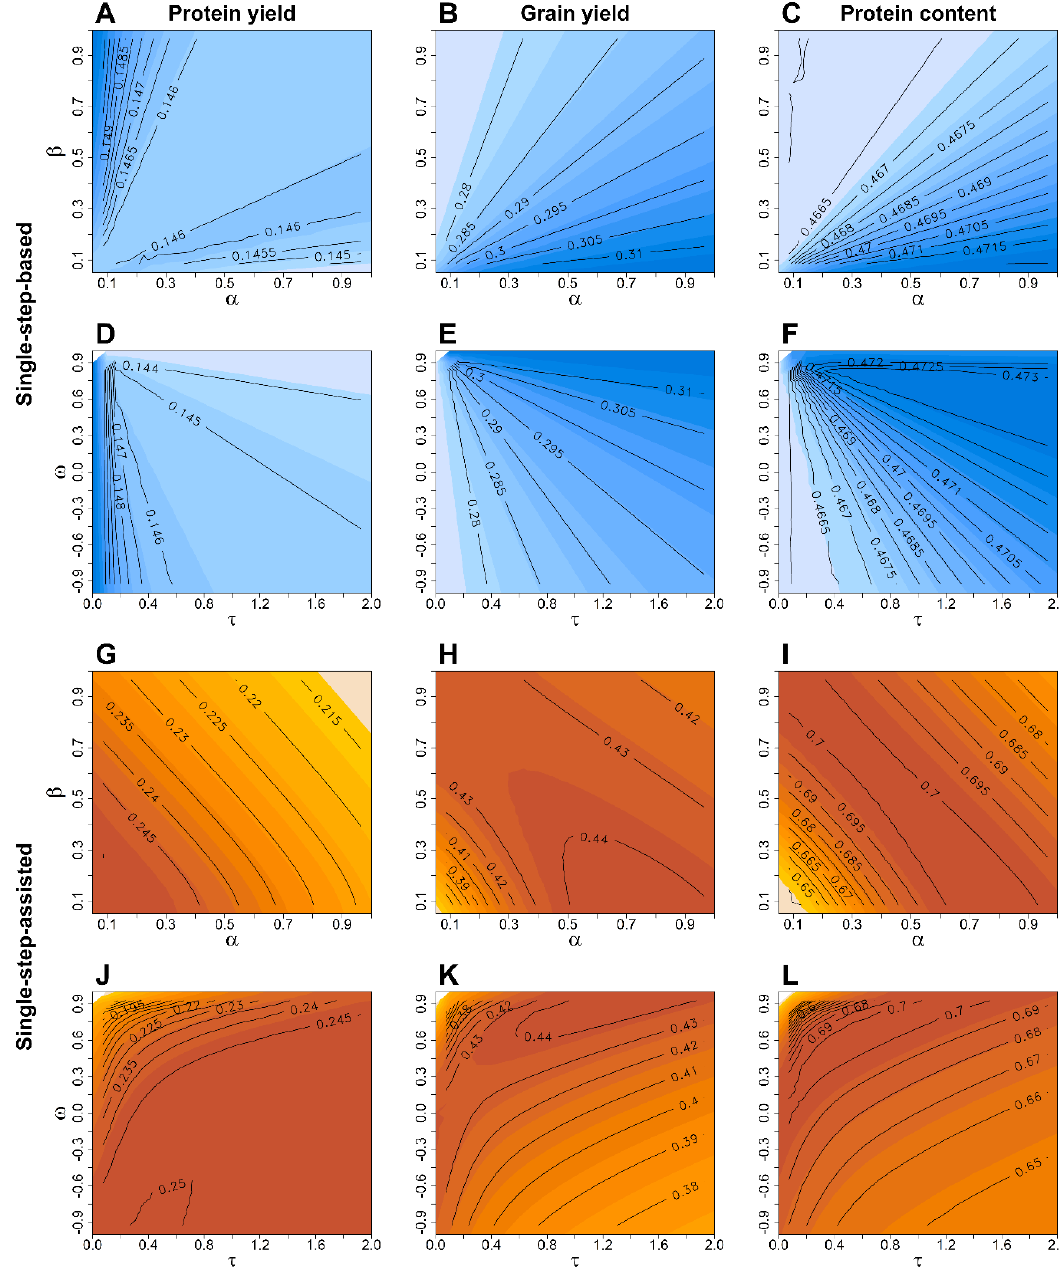
Figure 3. Average prediction accuracy for protein yield (first columns), grain yield (central column) and protein content (right column) obtained from the 50 times repeated resampling scheme with a 3-year training population in a single-step genomic prediction scenario where only lines in the training population are genotypes to derive single-step-based ( A – F ; blue coloured) and single-step-assisted predictions ( G – L ; red coloured) for the non-genotyped lines in the validation population with the latter exploiting preexisting information of the validation population from preliminary yield trials. The weights on the scaling factors α , β , τ and ω to create the relationship matrix H mod − 1 (Equation (7)) that blended pedigree and genomic relationship information were varied in a grid search, while the factors α and β were kept constant at α = 1 and β = 0 when varying τ and ω , whereas τ and ω were kept constant at ω = 1 and τ = 1 when modifying α and β . Isolines of same prediction accuracy for di ff erent combinations of the scaling factors are highlighted in black colour, while a darker colouring within the respective subplots A–L indicates a higher prediction accuracy for the particular model and scaling factor